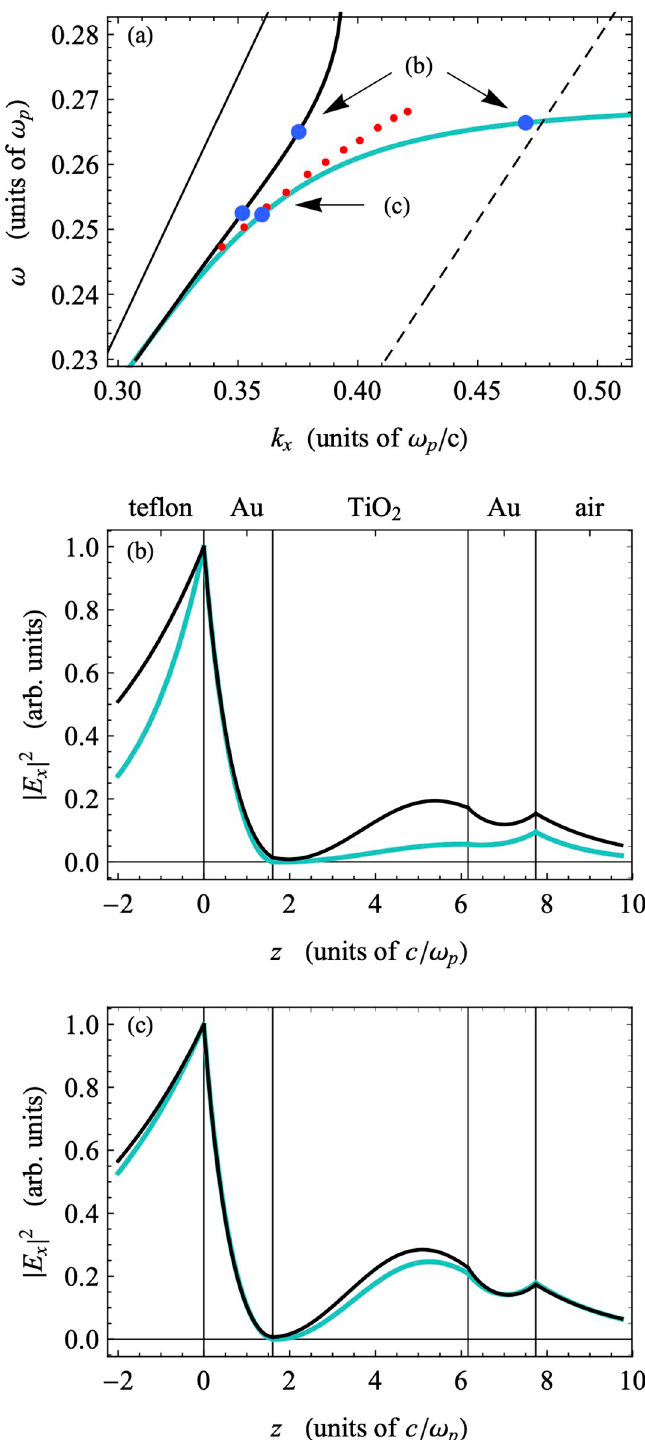
Fig 7. Magnification of experimentally-relevant dispersion region in Fig 6 and electric field amplitudes. a) the experimentally relevant region of the dispersion displayed in Fig 6; b) electric field amplitude (modulus squared) associated with point b on the dispersion plot; c) electric field amplitude (modulus squared) associated with point c on the dispersion plot. Red dots indicate the minima of the experimental ATR scans (see Fig 5).